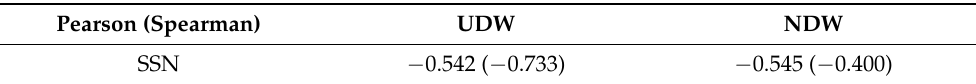
Figure 6. Monthly occurrence rates of the UDW (black), NDW (blue) and the SSN(red, dowloaded from https://www.sidc.be/silso/datafiles (accessed on 1 April 2022)). Table 4. Pearson and Spearman correlation coefficient between the monthly occurrence rates of the UDW and NDW with